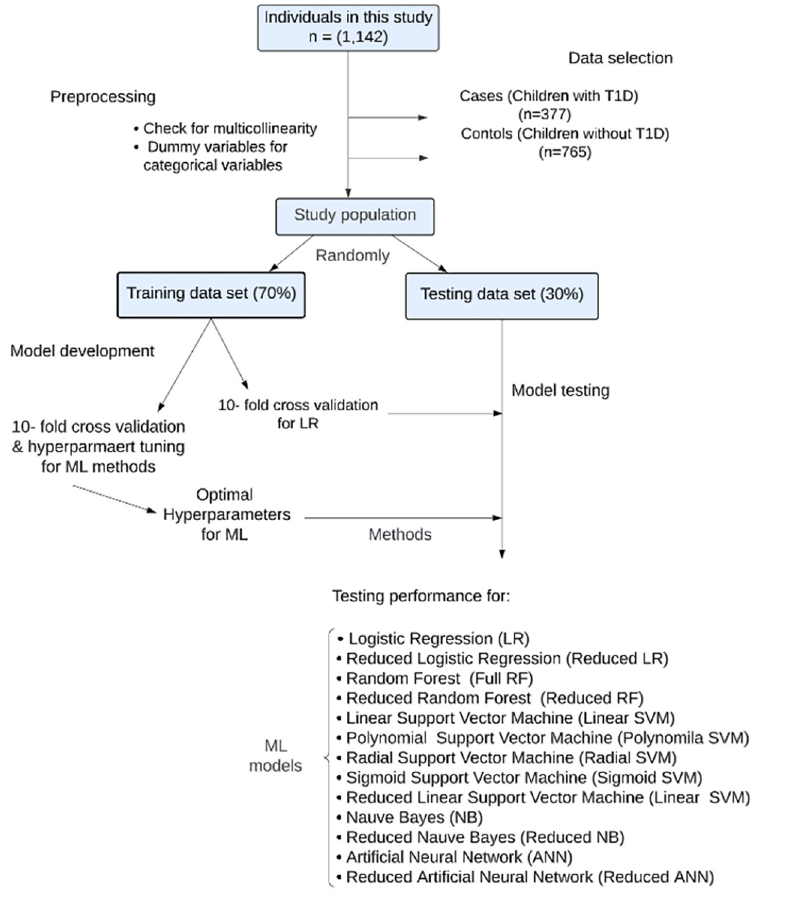
Fig 1. Flowchart of models